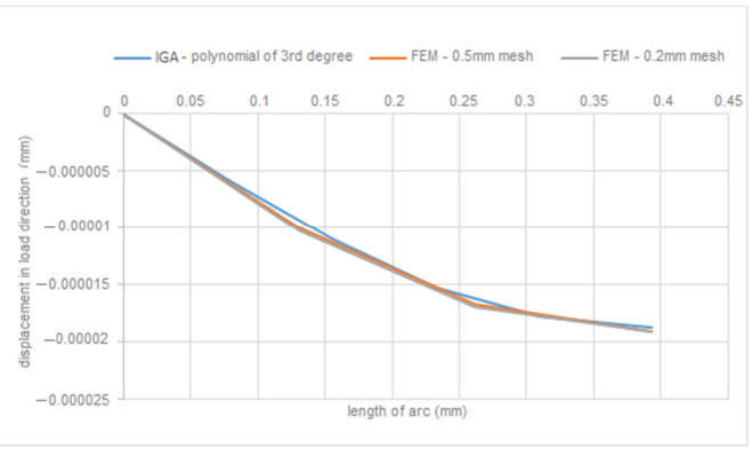
Figure 8. Comparison of obtained displacements. Table 2. Computed displacements of the points for the different solution methods.